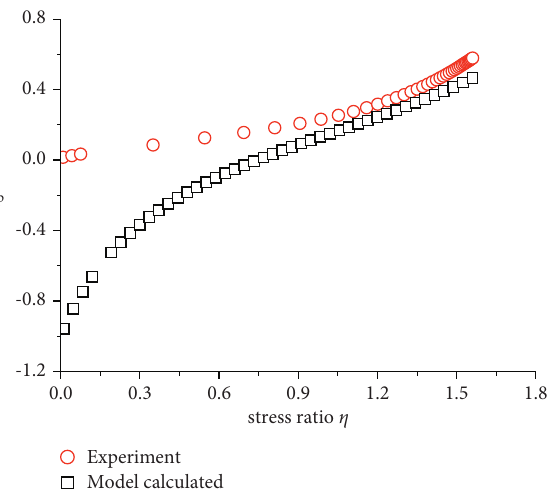
Figure 18: The evolution of v